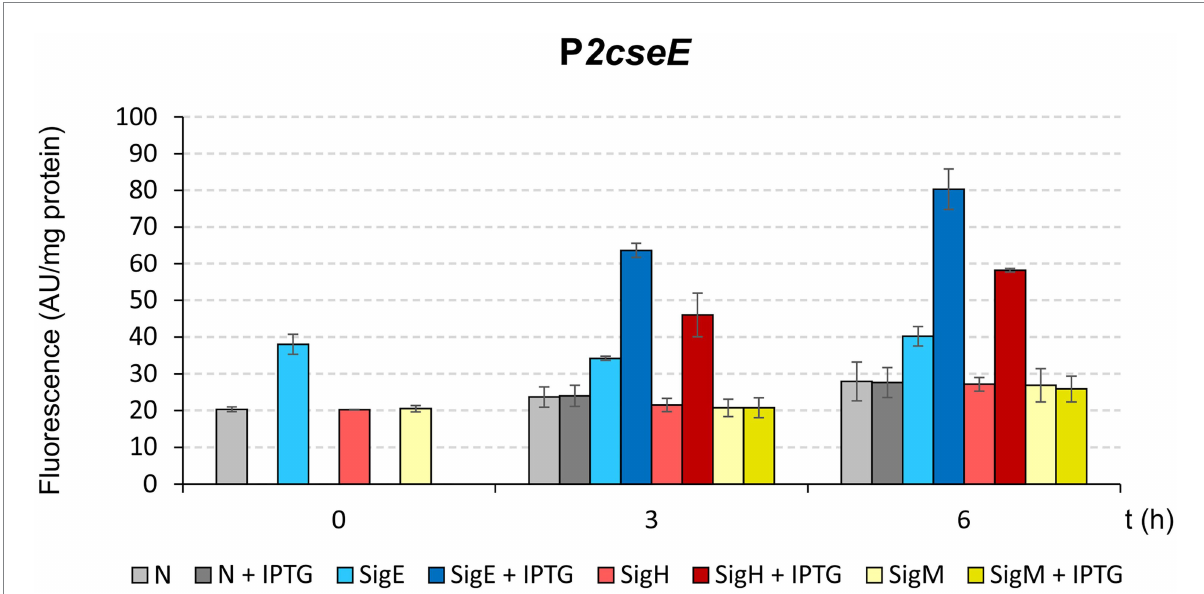
FIGURE 5 Determination of promoter P2 cseE activity initiated by sigE , sigH, or sigM overexpression using in vivo two-plasmid assay. Promoter activity was measured as GFPuv fluorescence intensity of cell extracts, and is shown as bars representing the respective sigma factors. The C. glutamicum strains carried the pEC-XT99A constructs overexpressing sigE , sigH, or sigM after IPTG addition (added at time point 0) and the promoter-test vector pEPR1 carrying the promoterless reporter gfp uv gene downstream of the target promoter P2 cseE . The strains harboring pEPR1 with the P2 cseE promoter and empty pEC-XT99A (gray bars) or sigM (yellow bars) were used as controls. AU, arbitrary units. The standard deviations of three biological replicates are depicted as error